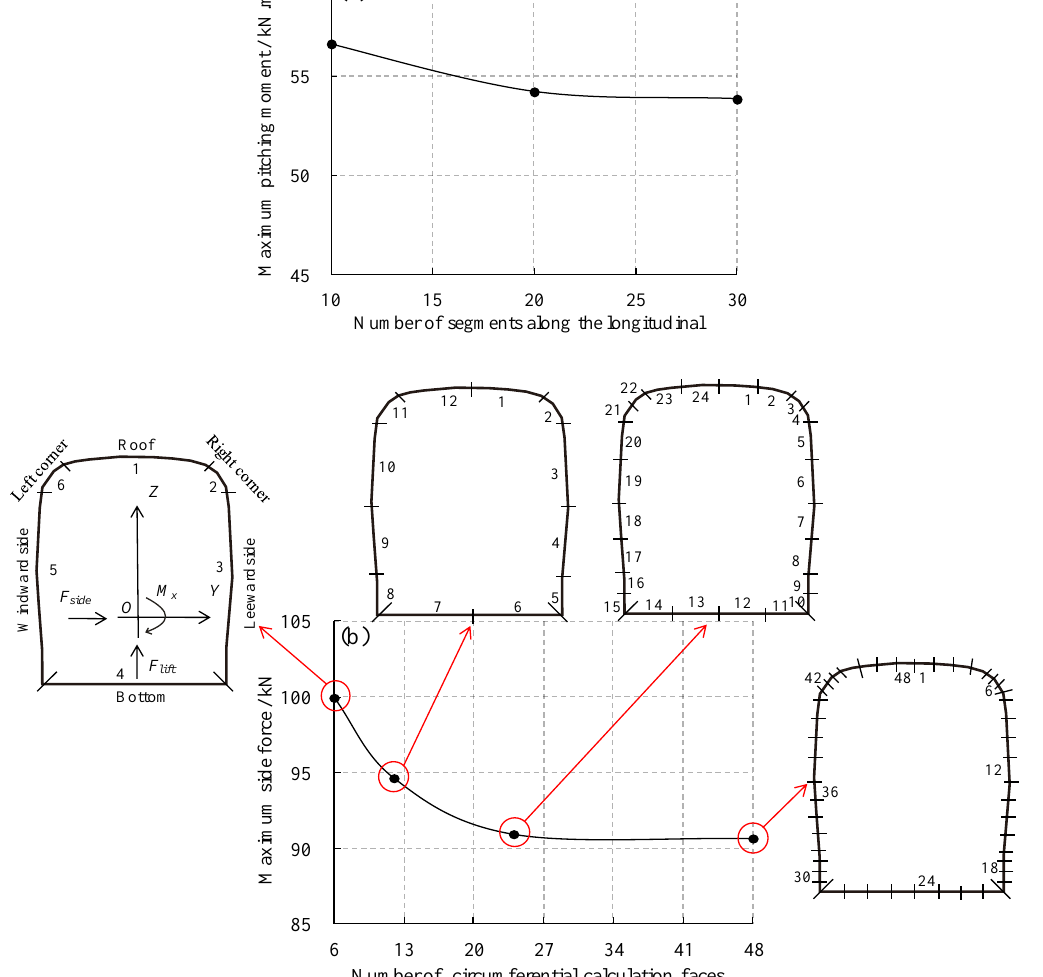
Figure 9. The target indicators under different conditions: ( a ) different numbers of longitudinal segments; ( b ) different numbers of circumferential calculation faces (train speed = 250 km/h; wind velocity = 25 m/s).